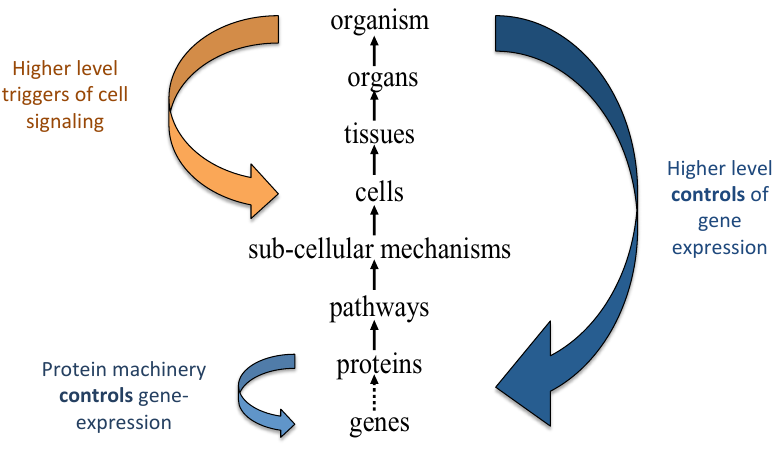
Figure 1. The reductionist ‘bottom-up’ causal chain (reproduced with permission from Noble, 2006) This begins with the central dogma that information flows from DNA to proteins (bottom dotted arrow), never the other way, and extends the same concept through all the higher